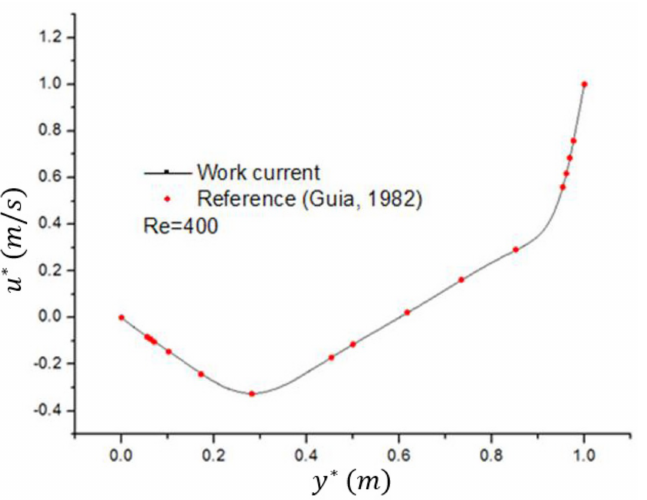
Figure 11. Velocity components within the